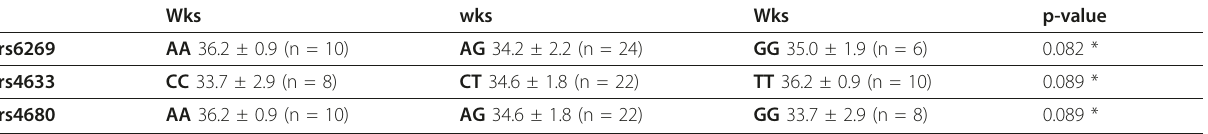
Table 6 COMT genotype and gestational age at birth (mean ± SD)